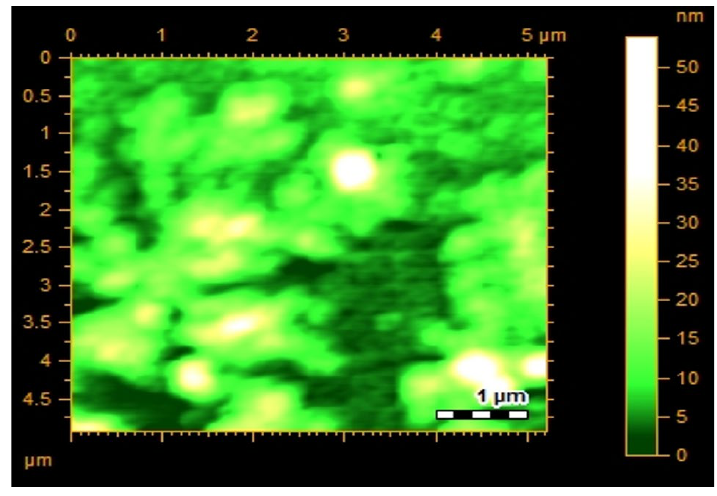
Fig. 4. AFM analysis of D. salicifolia gold Table 5. Antifungal activity of crude extract, different fractions and nanoparticles of D. salicifolia Microorganism